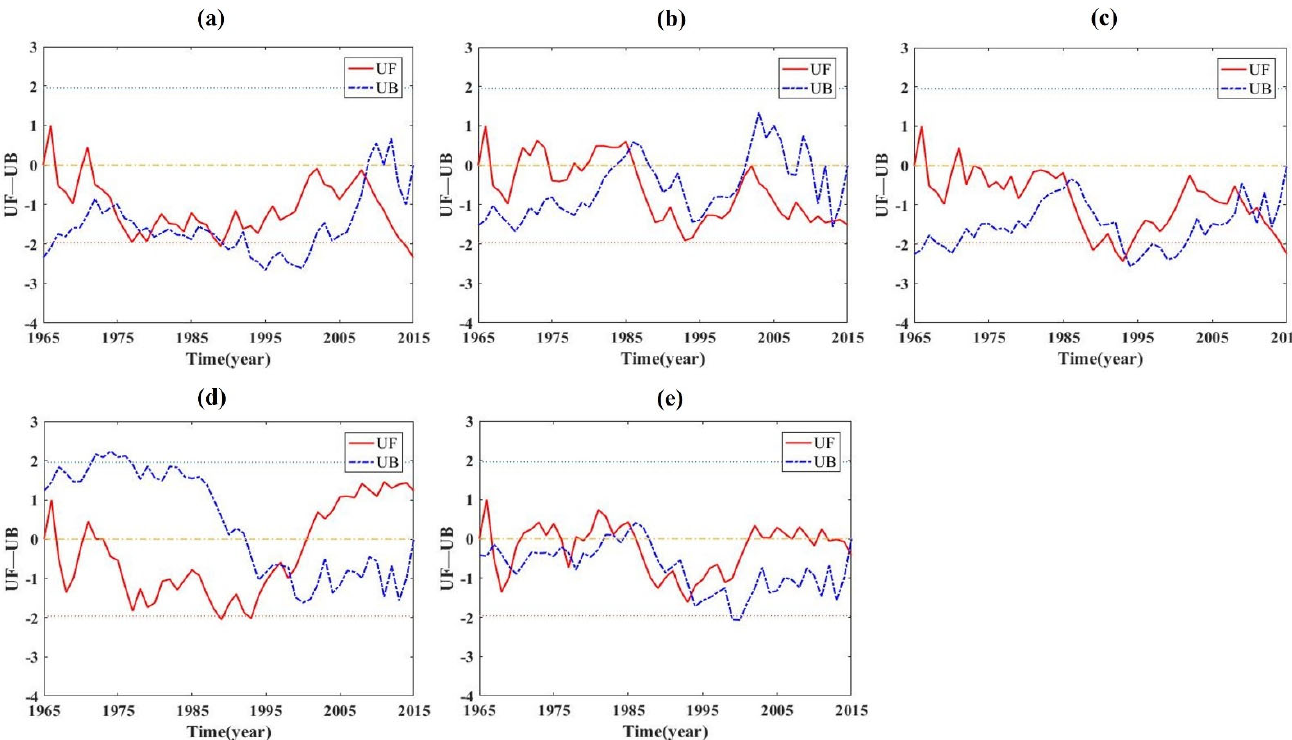
Figure 3. Abrupt change detection using Mann–Kendall test at five hydrological stations in 1965–2015: ( a ) CS station, ( b ) LP station, ( c ) VT station, ( d ) MK station, ( e ) PK station. UF, positive sequence statistics; UB, reversal sequence statistics.